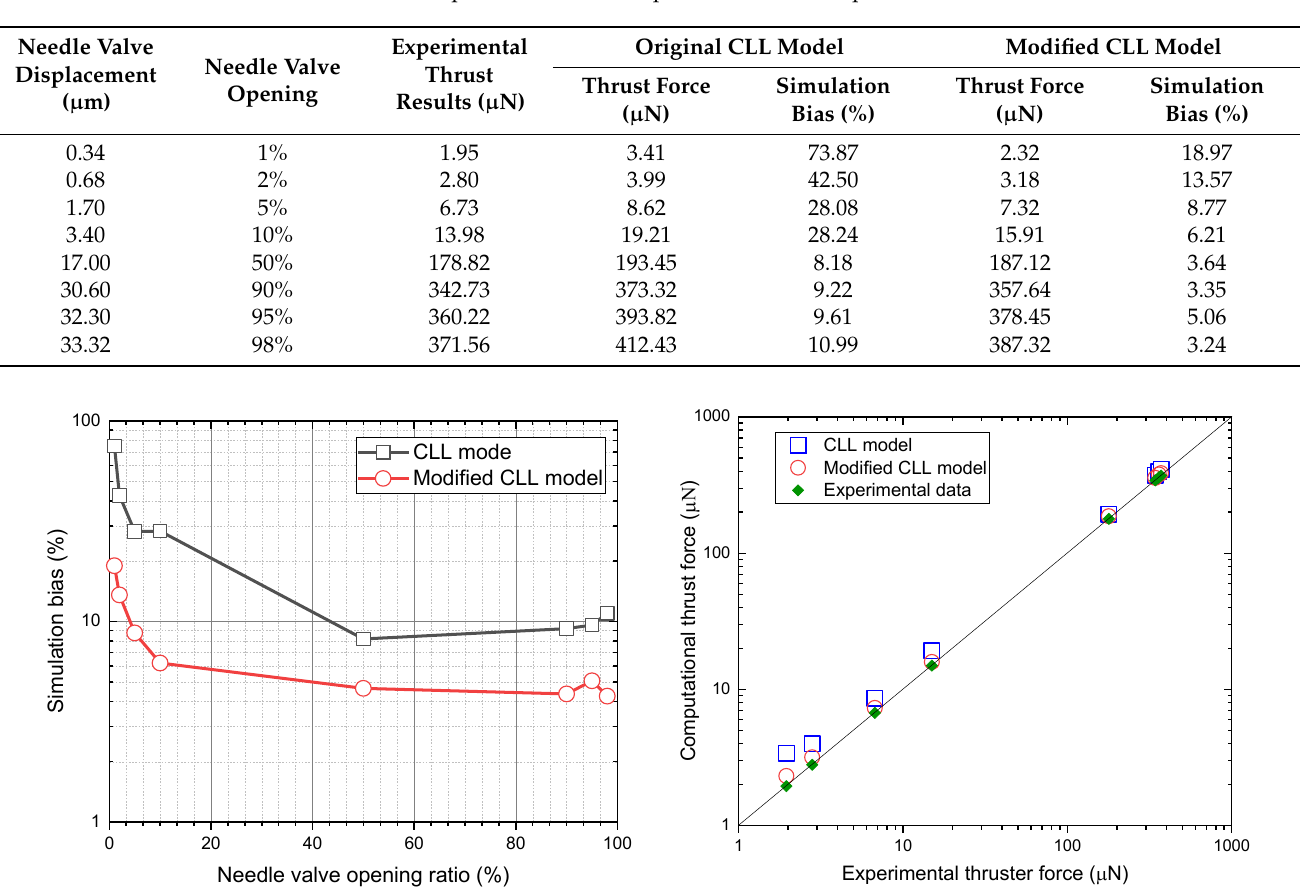
Figure 11. Comparisons between experimental and computational results by CLL model and its modified model.